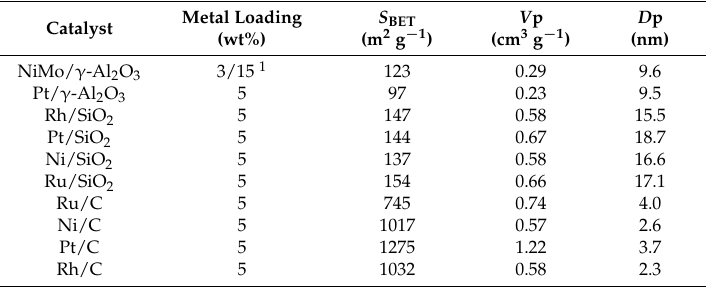
Table 1. Results from BET analyses.